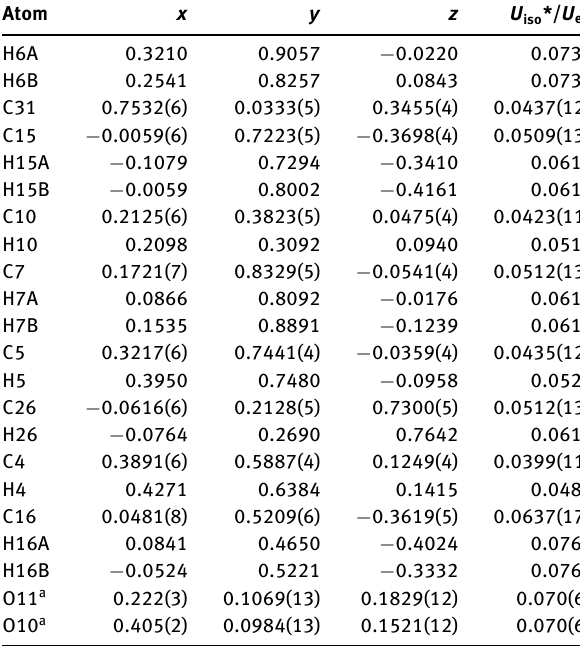
Table 2: Fractional atomic coordinates and isotropic or equivalent isotropic displacement parameters (Å 2 ).